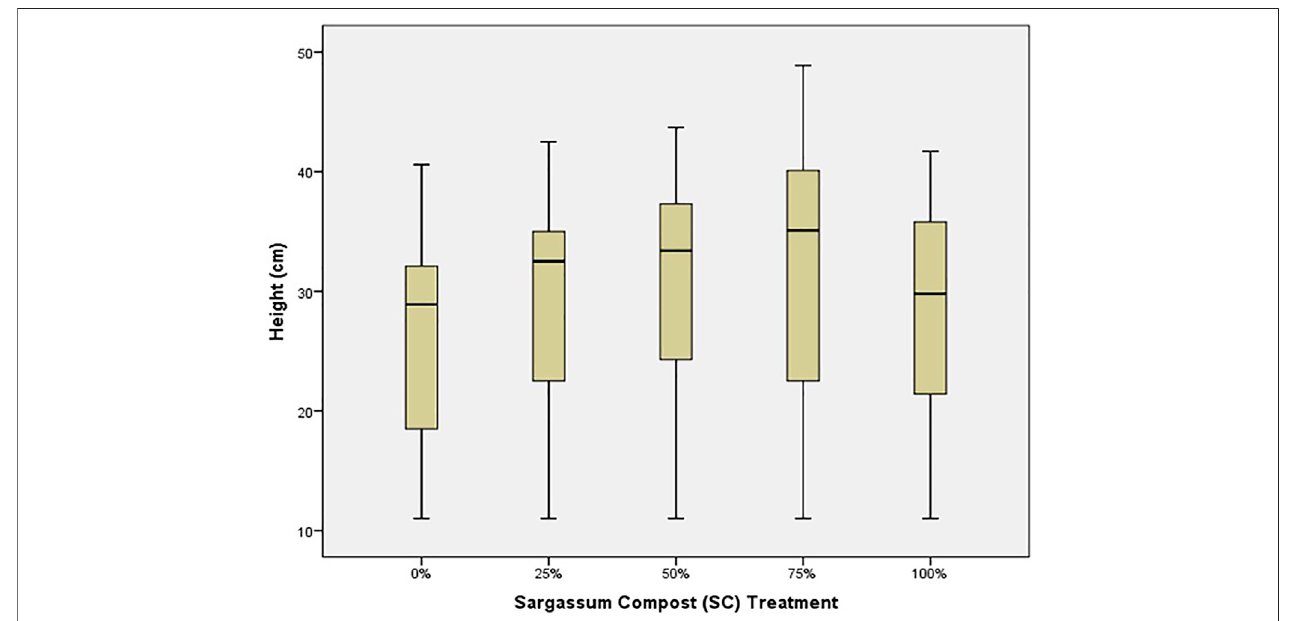
FIGURE 1 | Median seedling height (bar), 25 – 75% range (box), and non-outlier range (whisker) for red mangrove seedlings in each treatment, indicating the % Sargassum spp. compost (SC).